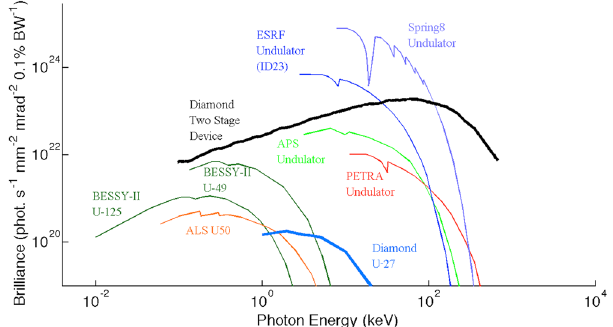
Figure 4. The peak brilliance of various third generation light sources compared to the X-ray pulse by the simulated Diamond storage ring beam. The lower emittance of 2.84 nm rad and shorter beam length of 7.68 mm of the storage ring beam enables the generation of X-ray pulses with photon energies peaking at 59